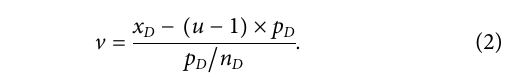
Frontiers in Physics |